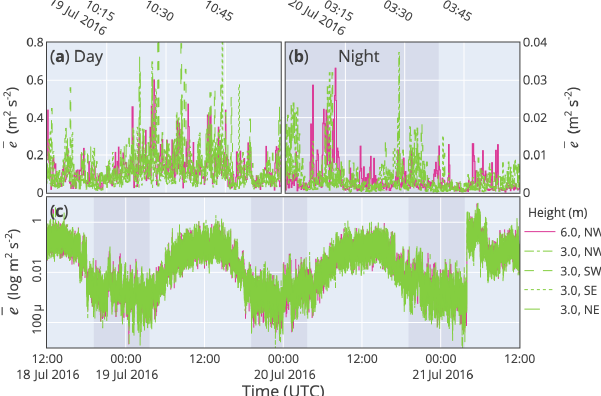
Figure 11. The turbulent kinetic energy (TKE; e ) was computed for corner locations at 3.0 or 6.0m above ground and shown for (a) an example daytime hour, (b) and an example nighttime-to-dusk hour and (c) the study period. Nighttime is highlighted with dark